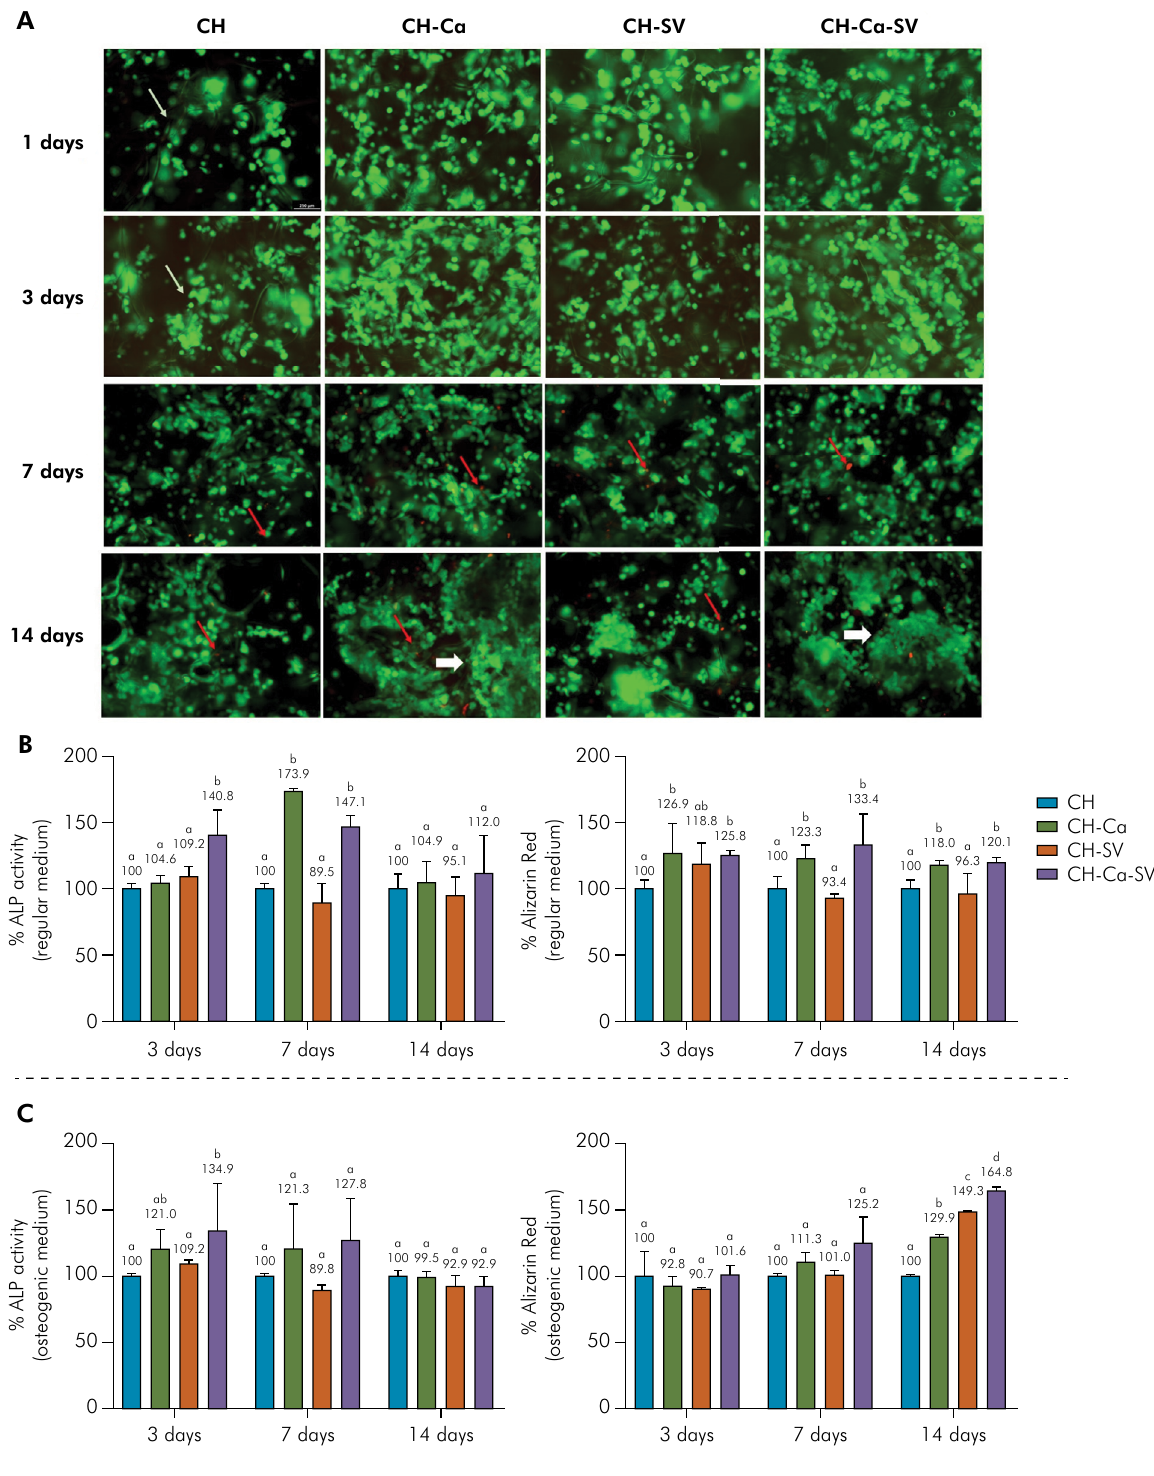
Figure 4. Direct contact experiment. (a) Representative images of live/dead (20x) assay. Green = live; Red = dead. Red arrows indicate the nuclei of dead cells stained with ethidium homodimer 1. Blue arrows indicate live cells stained with calcein AM. Large arrows indicate cell agglomerates at 14 days; (b) and (c) graphs representing the ALP activity and Alizarin Red tested with regular and osteogenic medium, respectively. Values represent means, and different letters indicate statistically significant differences between groups (one-way ANOVA followed by Tukey’s test. n = 6, p <